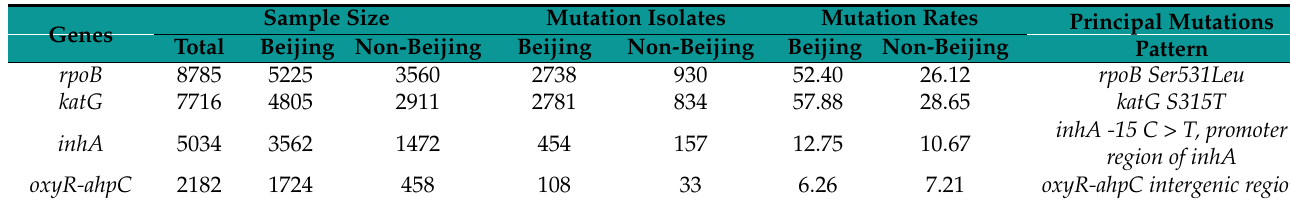
Table 2. Mutations prevalence for mutations of rpoB , katG , inhA and oxyR-ahpC .